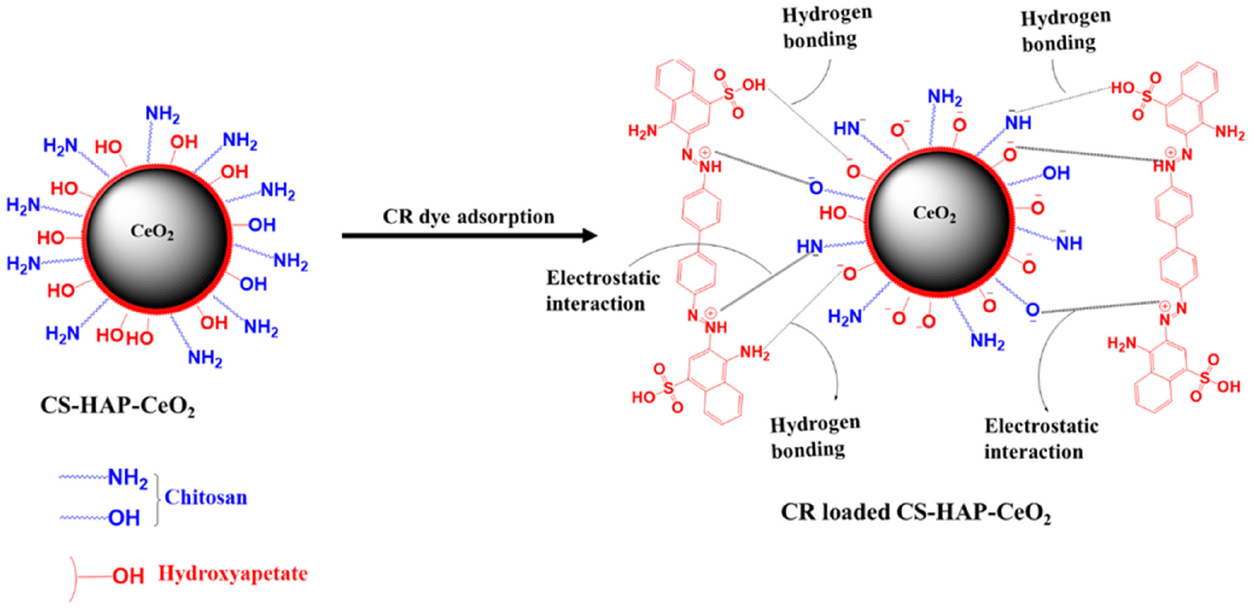
Figure 11. Mechanism of adsorption of CR onto CS-HAP-CeO 2 heterostructure.